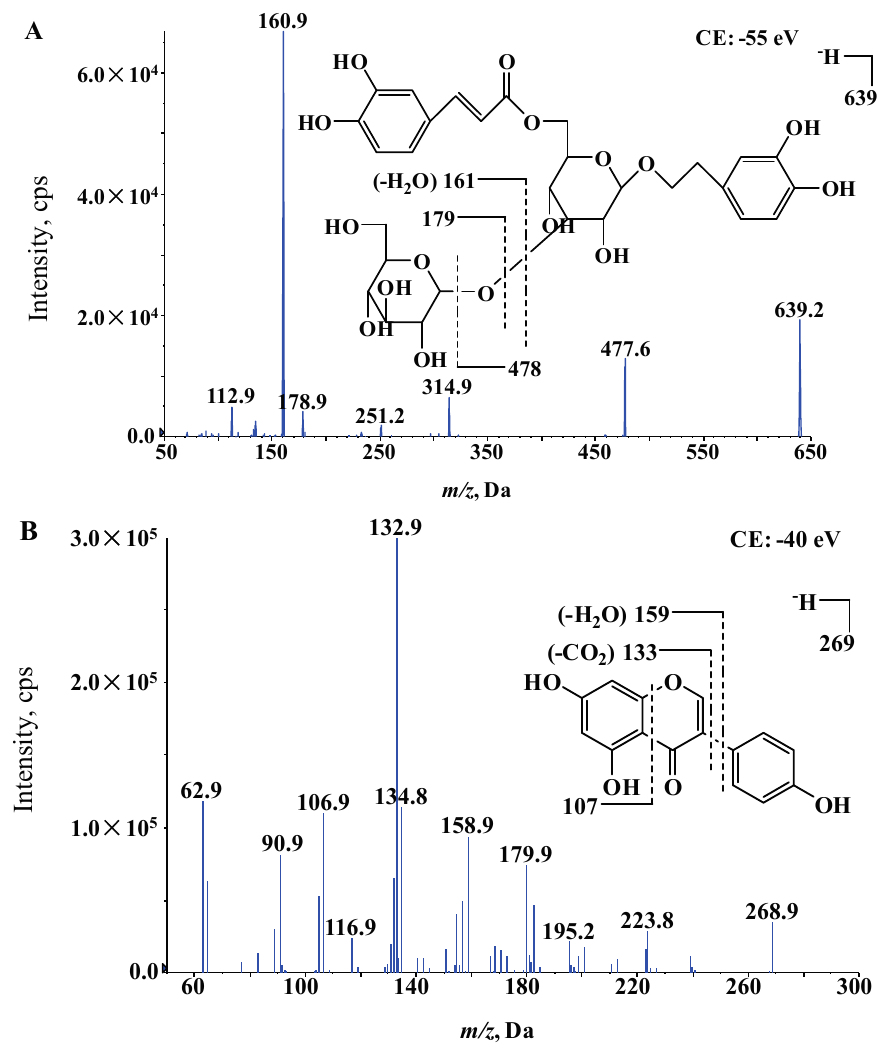
Figure 2. Full-scan product ion spectra of [M − H] − ions and fragmentation schemes for ( A ) PD and ( B ) genistein (internal